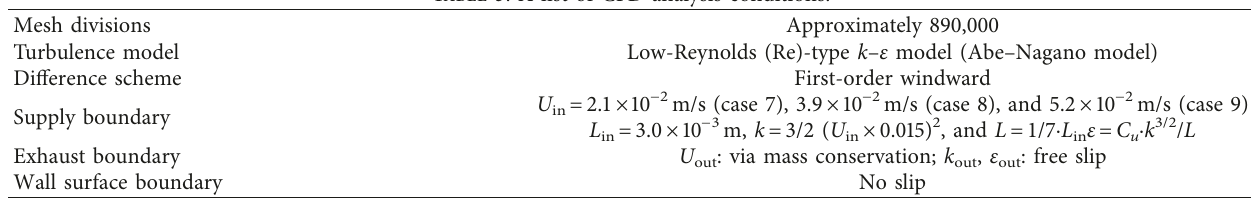
Table 5: A list of CFD analysis conditions.